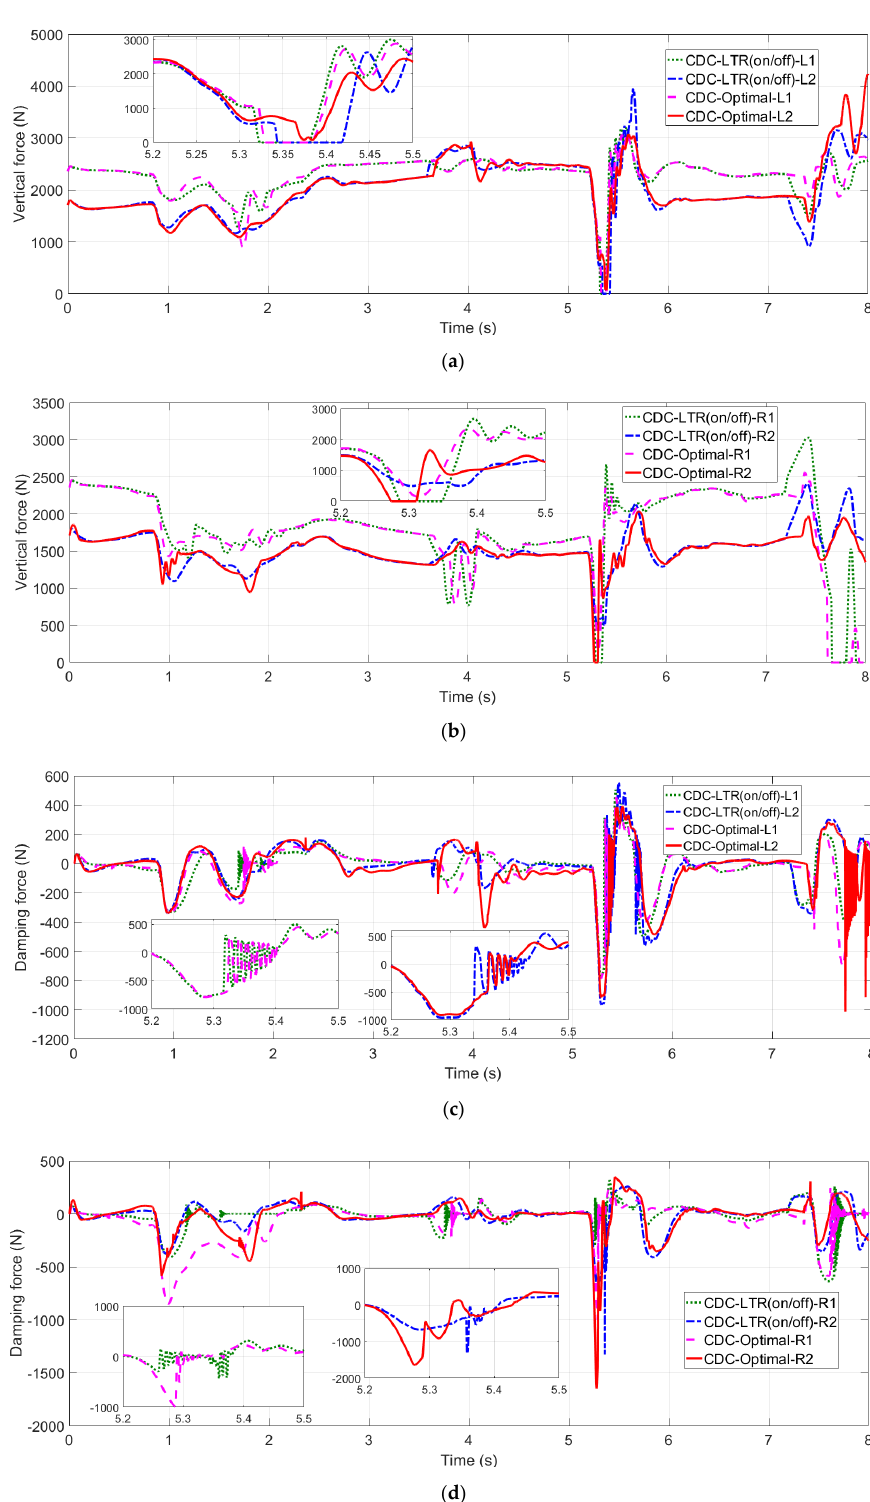
Figure 10. Vertical and damping forces of each wheel in crosswind test with CDC-LTR and CDC-ODDF. The details can be seen in the legend. ( a ) is the comparison result of the vertical forces of wheels on the left. ( b ) is the comparison result of the vertical forces of wheels on the right. ( c ) is the comparison result of the damping forces of wheels on the left. ( d ) is the comparison result of the damping forces of wheels on the right. L is short for left, and R is short for right. 1 represents the front axle, and 2 denotes the rear axle.